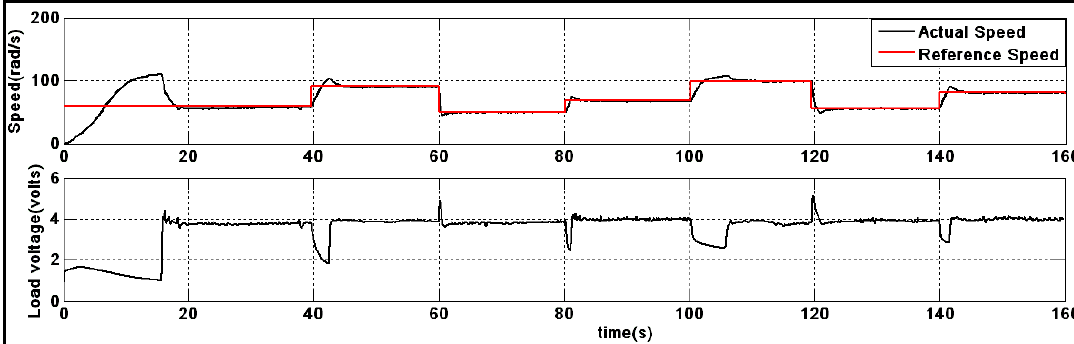
Figure 8. Speed tracking and load voltage under the adaptive SMC system. Friction quantity is considered unknown by the SMC and the tracking performance for speed and voltage is still good, as illustrated in Figure 9, highlighting the robustness of the control system.